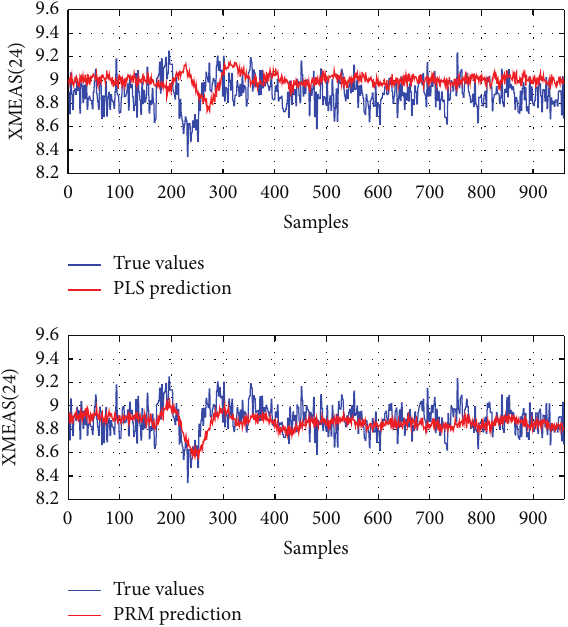
Figure 5: Quality-related indicator prediction using PLS and PRM with 15%